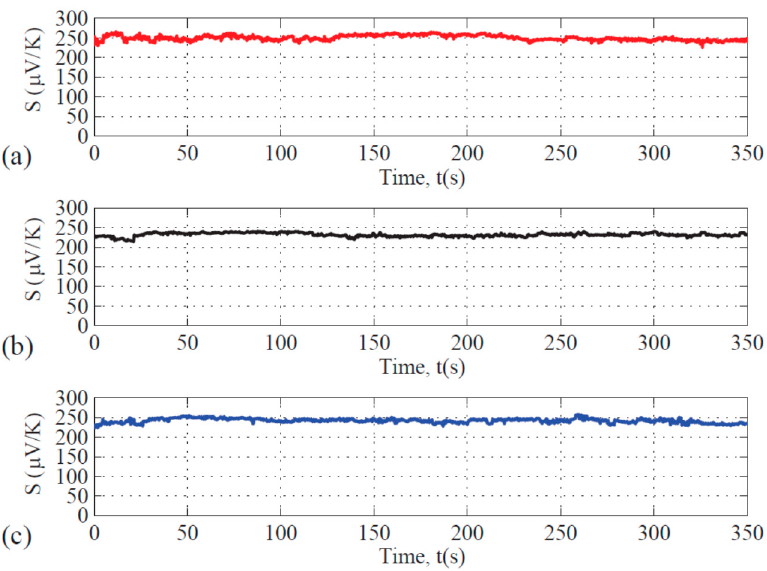
Figure 6. Time-dependent Seebeck coefficient results of the nanostructure obtained at Δ T = 5 °C to show the reproducible behavior of the nanostructure: ( a ) from specimen 1, ( b ) from specimen 2, ( c ) from specimen 3.